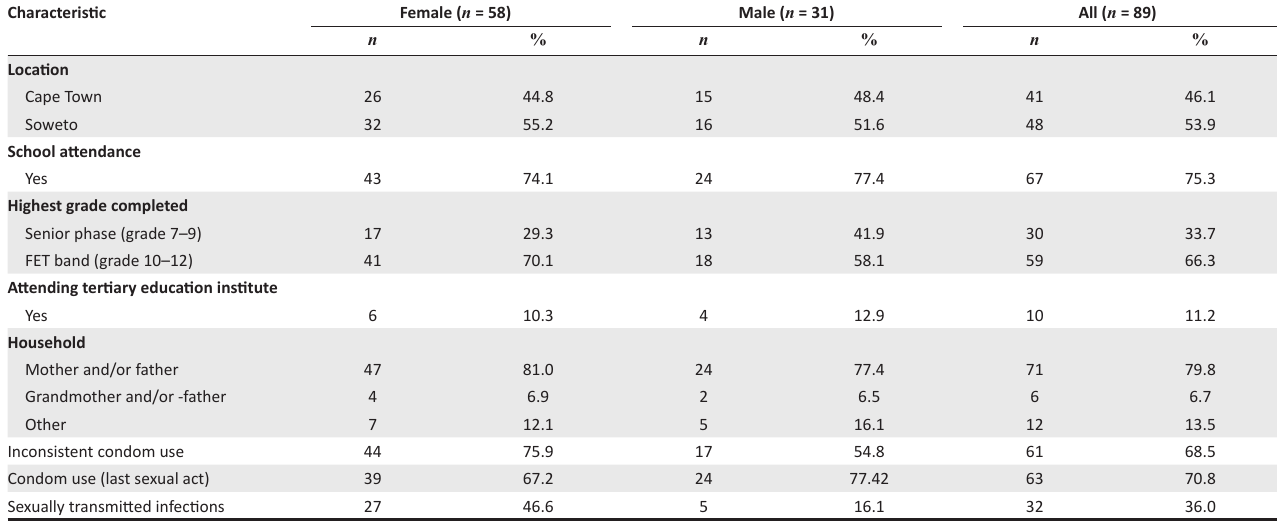
TABLE 1: Baseline characteristics.